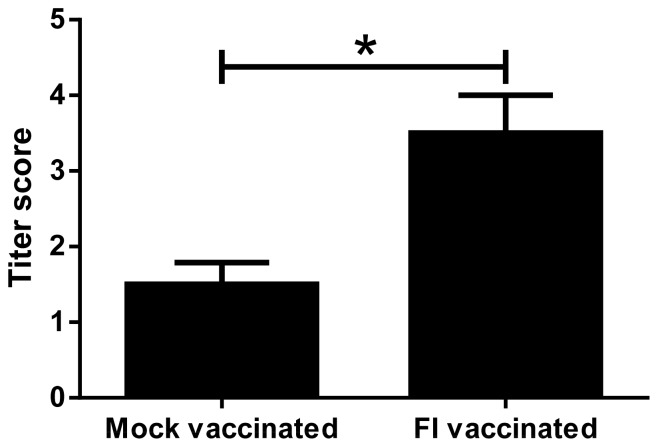
Serum neutralization titers of FI-RSV-vaccinated lambs (FI-vaccinated) (n = 4) were significantly increased compared to mock-vaccinated lambs (n = 4) (*P<0.05).Error bars = SEM.